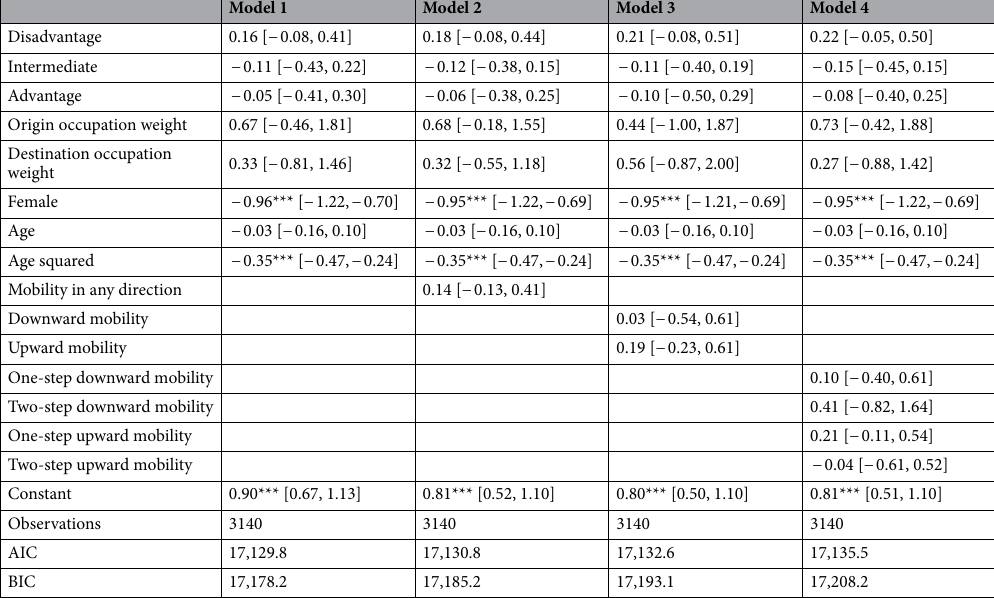
Table 3. DRM parameters estimation [95% confidence interval] for age acceleration indexed by the Horvath algorithm, UK Household Longitudinal Study, 2010–2012. Models with covariates plus: (1) no mobility variable; (2) any direction mobility variable; (3) variables to indicate upward or downward trend; (4) variables to indicate one step, two step upward or downward trend. 95% confidence intervals in brackets. ***p < 0.001.